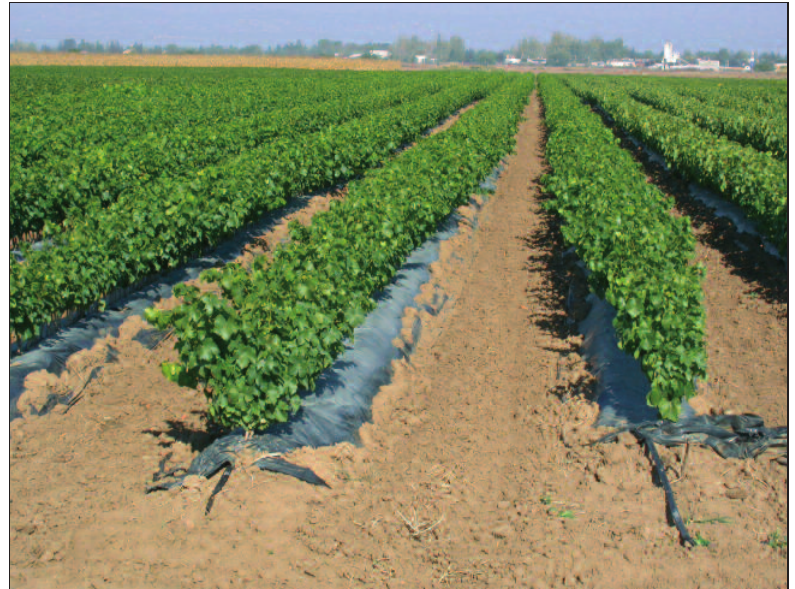
Fig. 18. Qualified grafted clones in